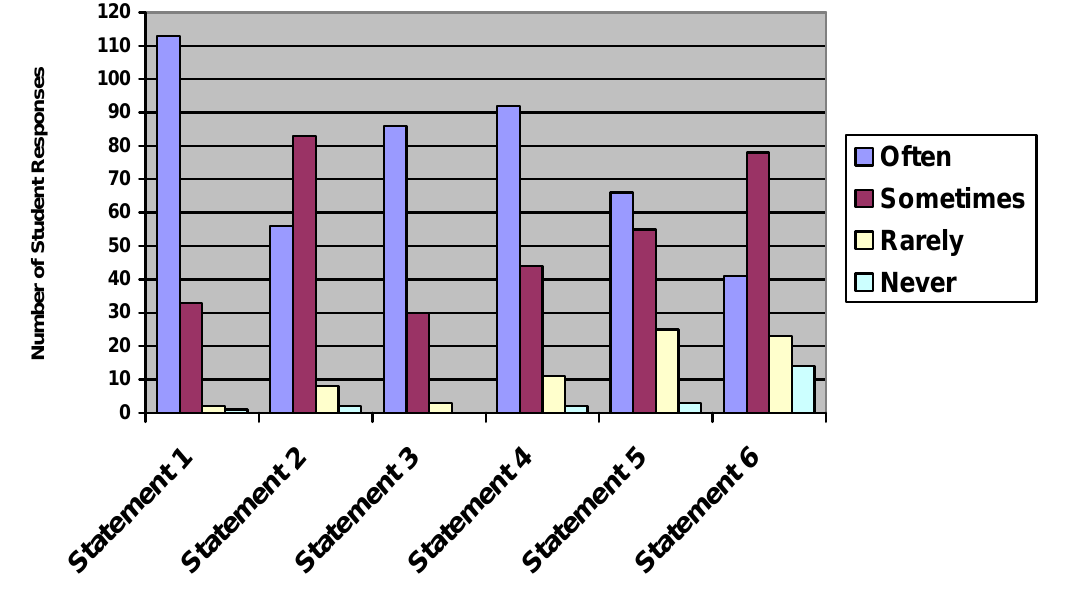
Figure 1. Student Implementation Survey from Week One prior to implementation of posting and communicating daily learning